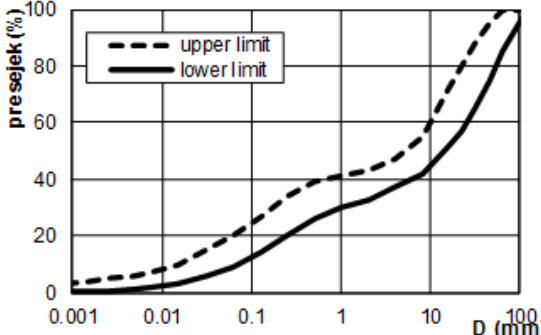
Figure 22. Calculated ranges of soil mixture to achieve the required hydraulic conductivity ( k < 10 − 6 m/s ) and